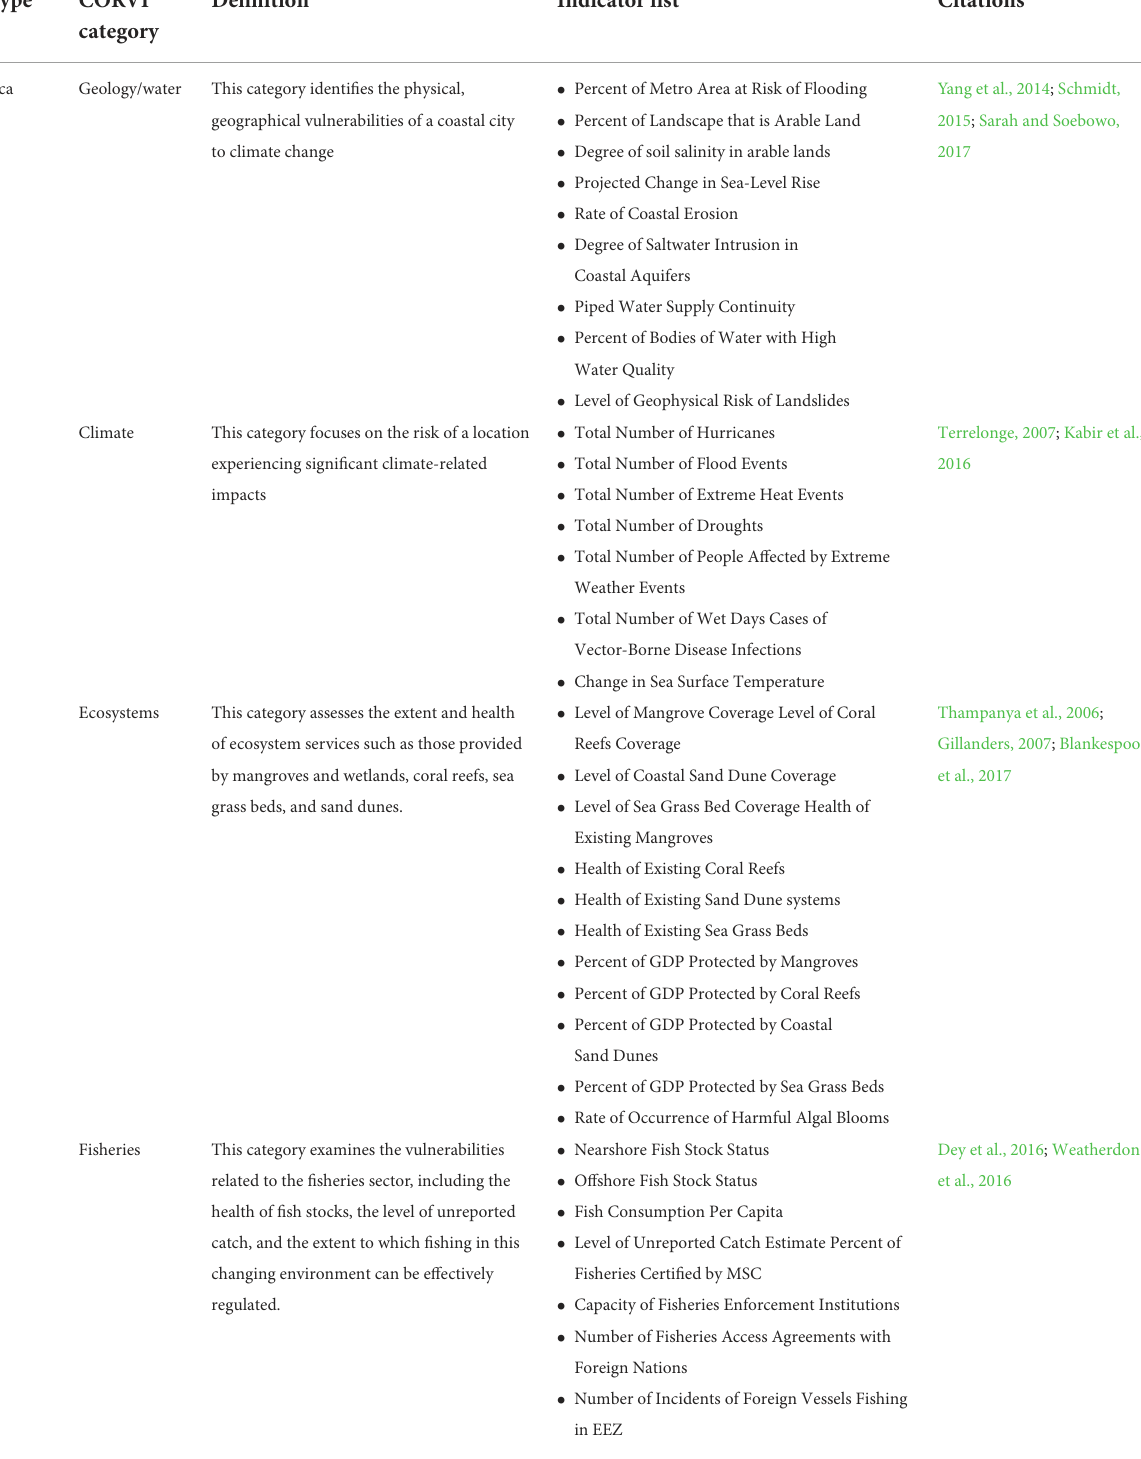
TABLE 1 Dimensions of climate-ocean risk and